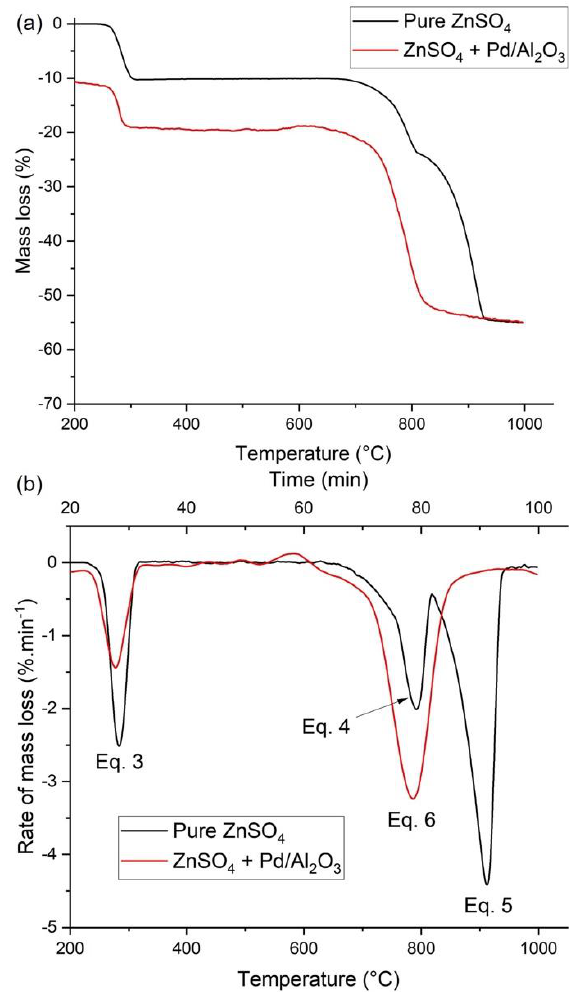
Figure 4. Thermogravimetric analyses of the thermal decomposition of ZnSO 4 · H 2 O in the presence and absence of Pd/Al 2 O 3 : ( a ) weight loss as a function of temperature; ( b ) DTG signal.